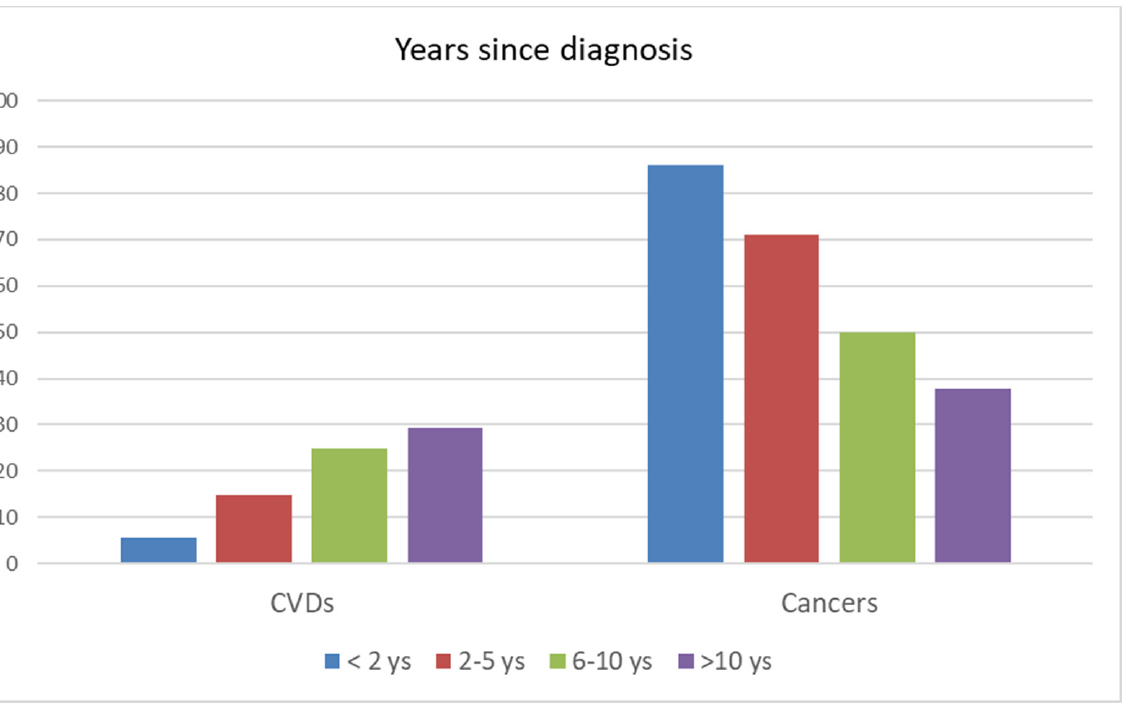
Figure 1. Percentage of deaths from cardiovascular disease and malignancy in cancer survivors by year of cancer diagnosis. Reggio Emilia, Italy, 1996–2019.